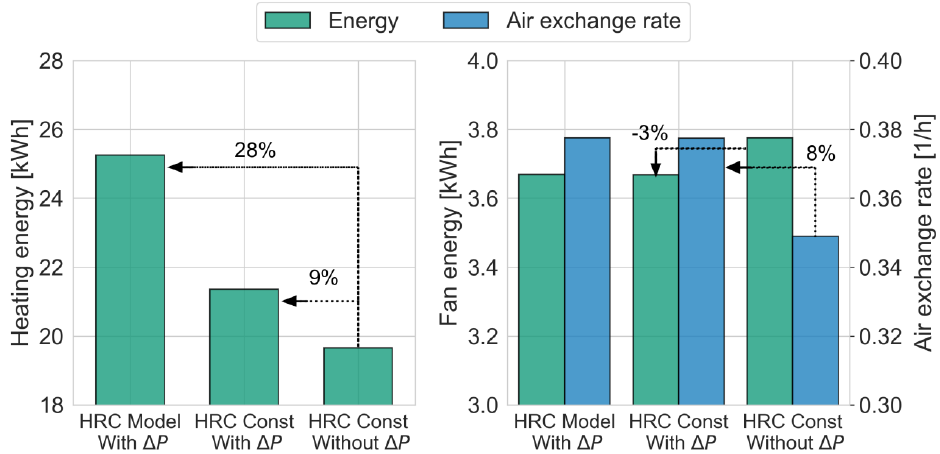
Figure 20. Relative increase in heat losses due to ventilation and air exchange rate for the three simulation scenarios (HRC Model = model-based; HRC Const = constant efficiency).